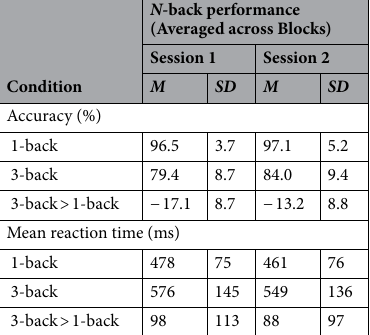
Table 1. Accuracy and mean reaction time.